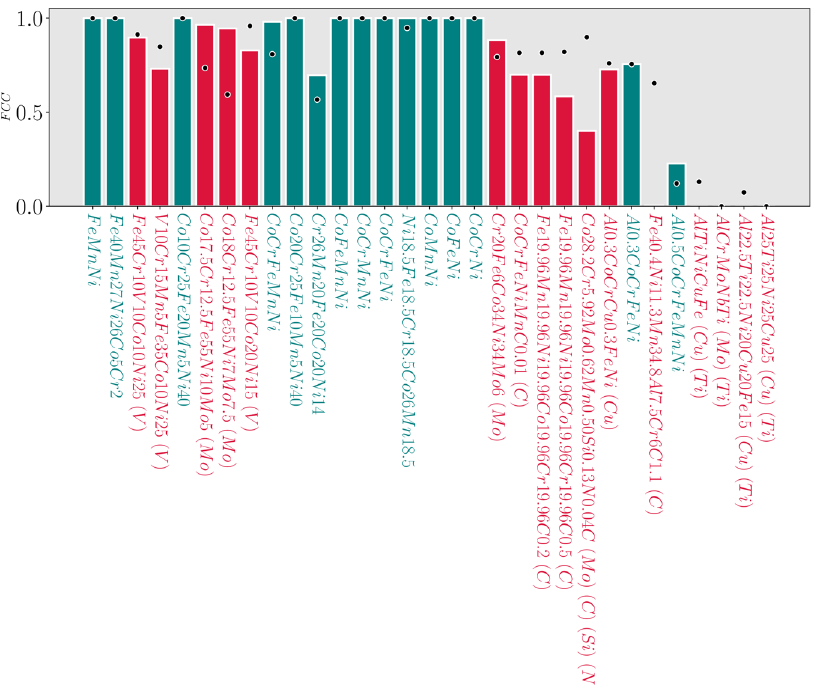
Fig. 8 FCC prediction. DNN regressor predictions for the FCC phase in alloys experimentally characterized as single FCC phase at annealing temperatures of 800 °C or higher. Those alloys with all elements considered in the training system and those which are not, are colored green and red, respectively. Labels for the alloy correspond to the stoichiometry of the alloy and in parentheses the extra elements not considered in the training. Black dots represent the FCC phase fraction prediction using Thermo-Calc single equilibrium running on the TCHEA5